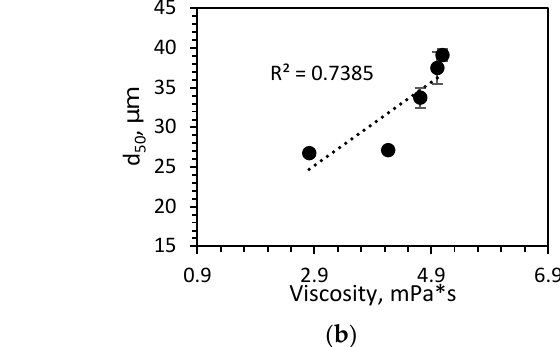
Figure 7. Effect of surface tension on the median powder size d 50 for the steels modified with selenium [17], sulfur [11] and sulfur with phosphorus. R² = 0.7339